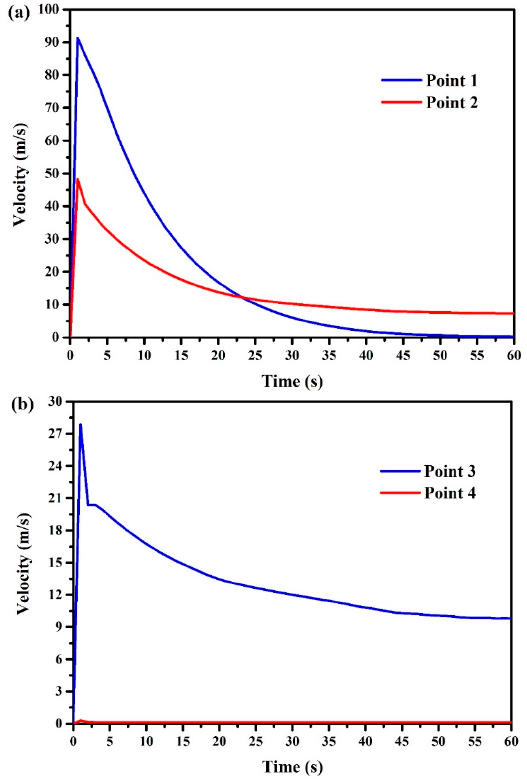
Figure 6. ( a ) Velocity distribution curves of monitoring points inside the pipeline. ( b ) Velocity distribution curves of monitoring points outside the pipeline.